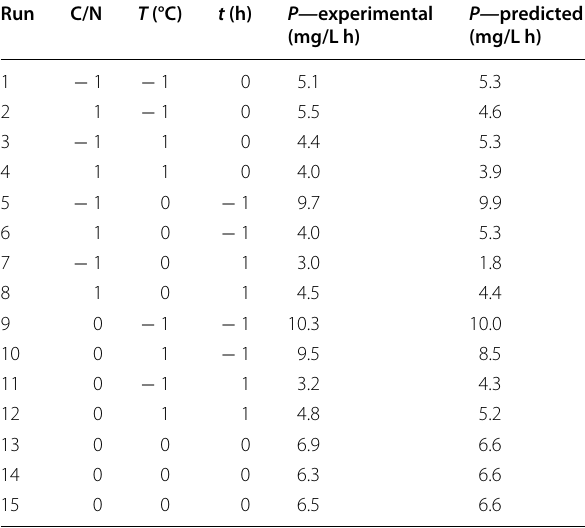
Table 3 Factor values for independent variables and response variable (experimental and predicted) of screening experiments to optimize fermentation